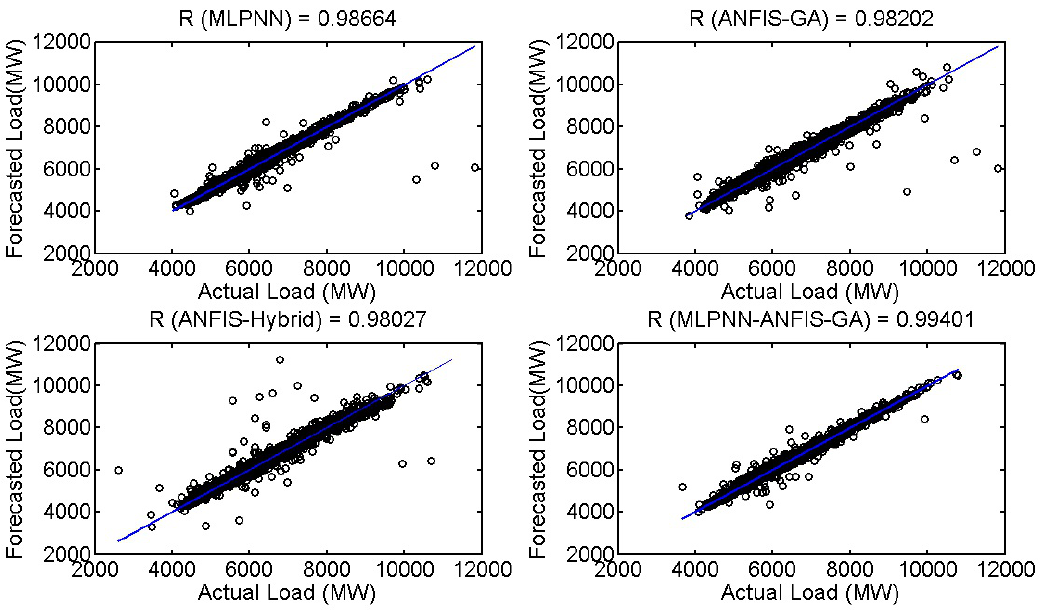
Figure 10. Correlation coefficient for MLPNN, ANFIS-Hybrid, ANFIS-GA, and MLPNN-ANFIS- GA models.